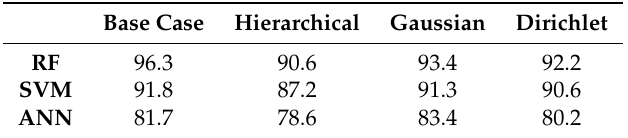
Table 4. Prediction results for each model type. Random forests (RFs), support vector machines (SVMs), and artificial neural networks